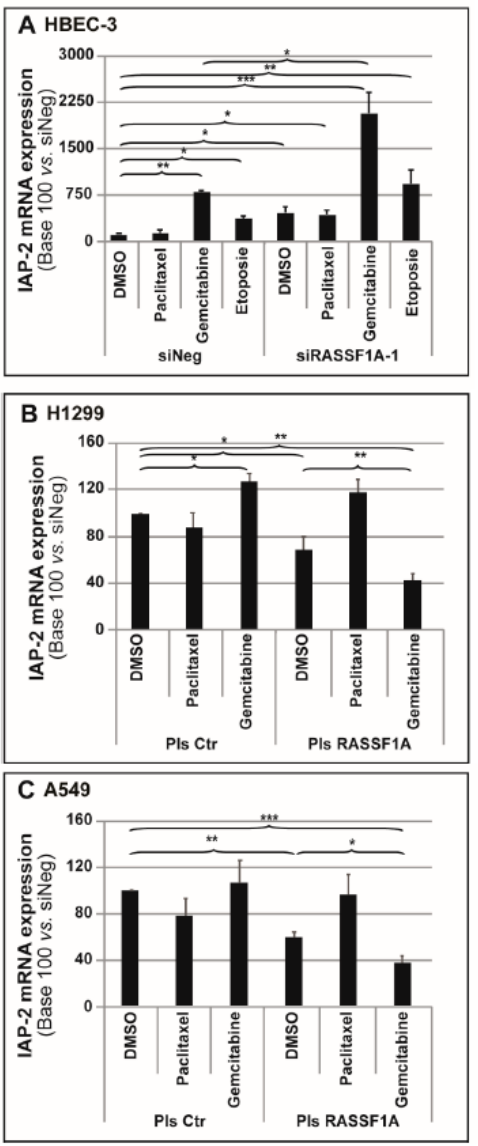
Figure 3. Gemcitabine treatment coincides with strong IAP-2 expression following RASSF1A depletion. HBEC-3 cells were transiently transfected with siNeg and siRASSF1A-1, whereas A549 and H1299 cells were transfected with plasmid coding wild-type RASSF1A. When indicated, 24-h post-transfection cells were treated for a further 24 h with paclitaxel (10 nM), gemcitabine (250 nM), or etoposide (50 µ M). ( A – C ) mRNA expression of IAP-2 was examined using RT-PCR in ( A ) HBEC-3, ( B ) H1299, and ( C ) A549. S16 was employed as internal control. The data are expressed as the mean ± SEM from three individual experiments. The statistical significance was determined using a Student’s t -test. * p < 0.05; ** p < 0.01; *** p <